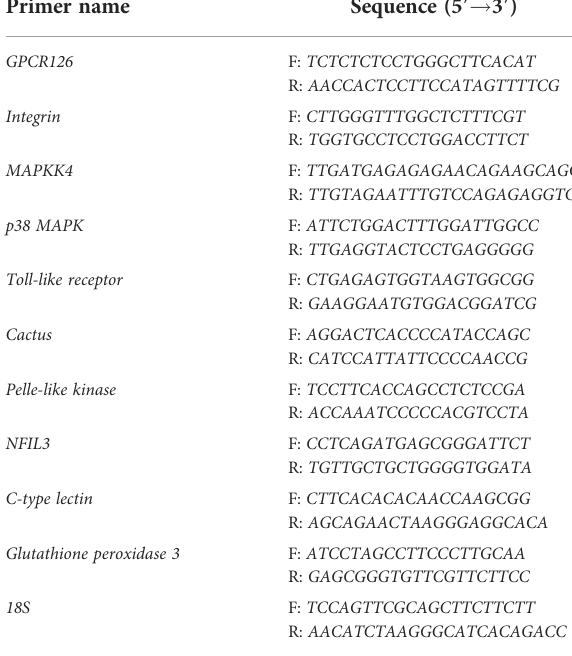
TABLE 1 Speci fi c primers used to in